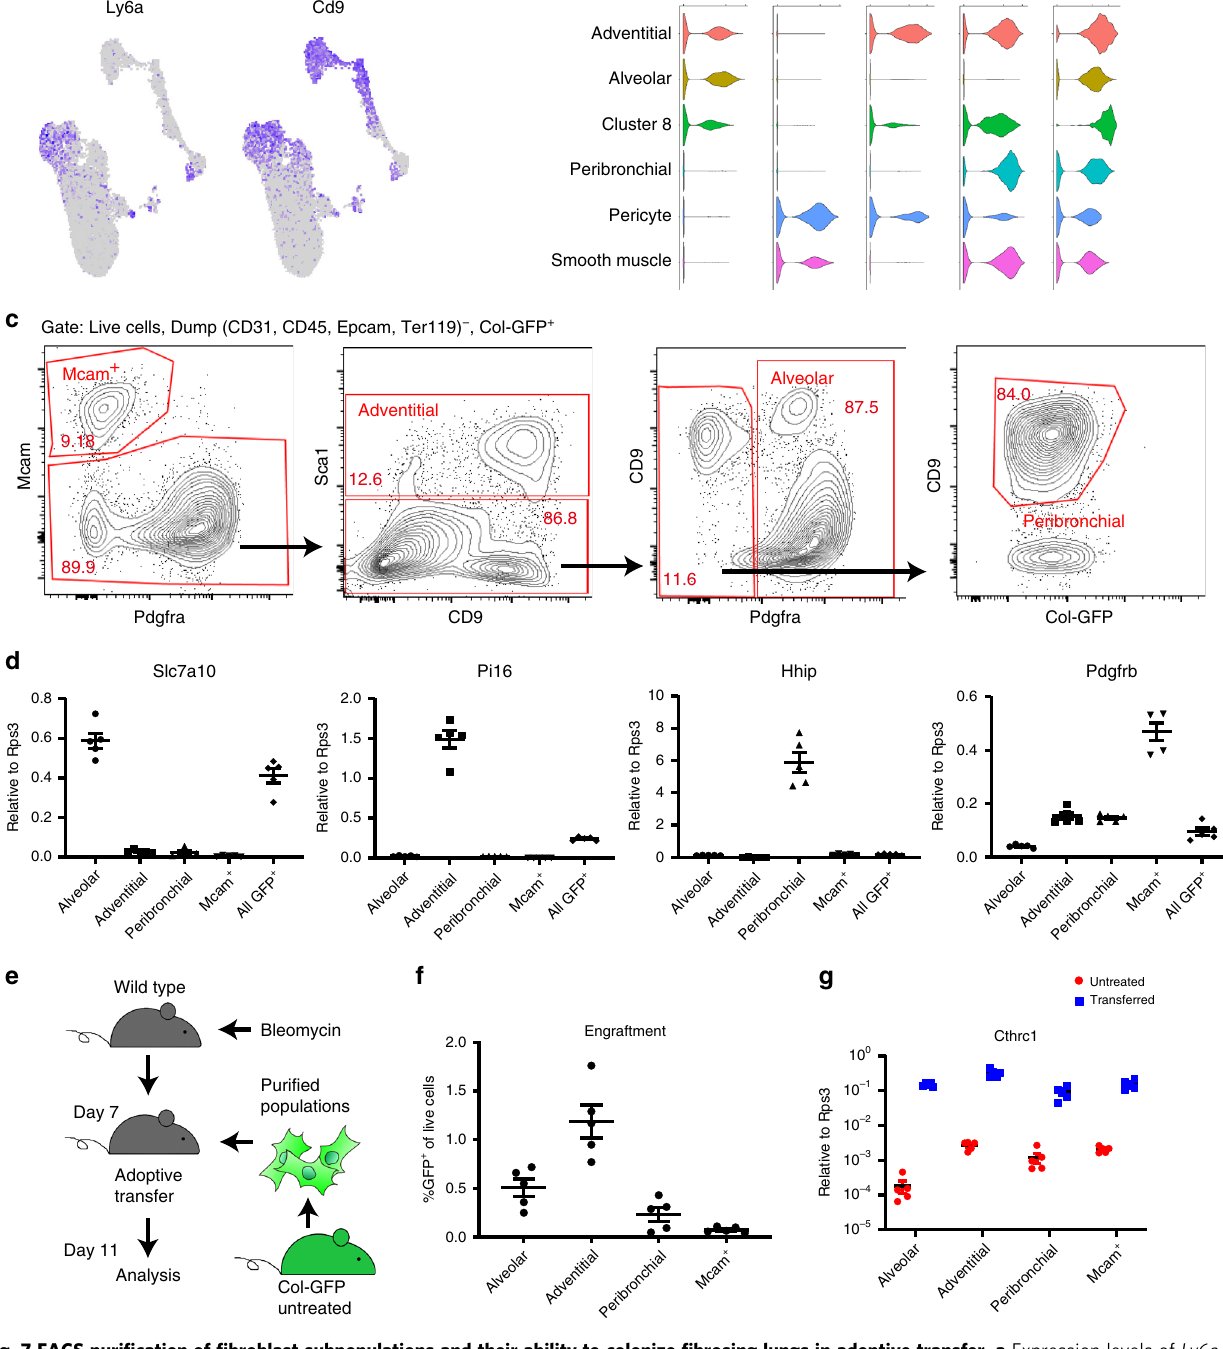
Fig. 7 FACS puri fi cation of fi broblast subpopulations and their ability to colonize fi brosing lungs in adoptive transfer. a Expression levels of Ly6a and Cd9 on UMAP plots from murine data. b Violin plots showing expressions of surface markers on collagen-producing populations. c Gating strategy to purify Mcam + cells, adventitial fi broblasts, alveolar fi broblasts, and peribronchial fi broblasts from untreated lungs. d qPCR analysis of puri fi ed cells from untreated lungs. n = 5 mice. e Schematic for the adoptive transfer experiment. f The number of GFP + cells in host lungs were analyzed. n = 5 mice. g qPCR analysis of puri fi ed GFP + cells from the host lungs. Cells puri fi ed from untreated lungs were used as control. n = 5 mice. c , d , f , g Data are representative from two experiments. Source data are provided as a Source Data fi le. d , f , g Data are means ±